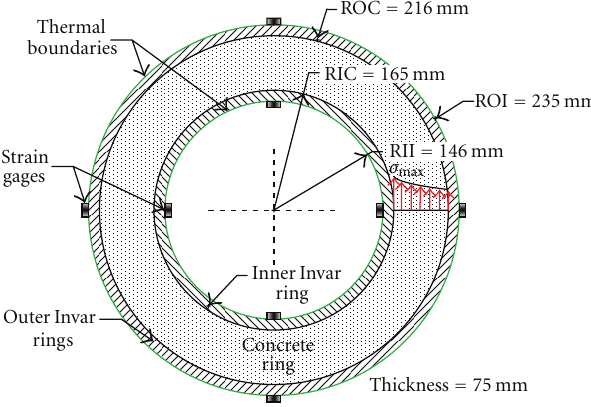
Figure 1: Schematic overview of the finite element